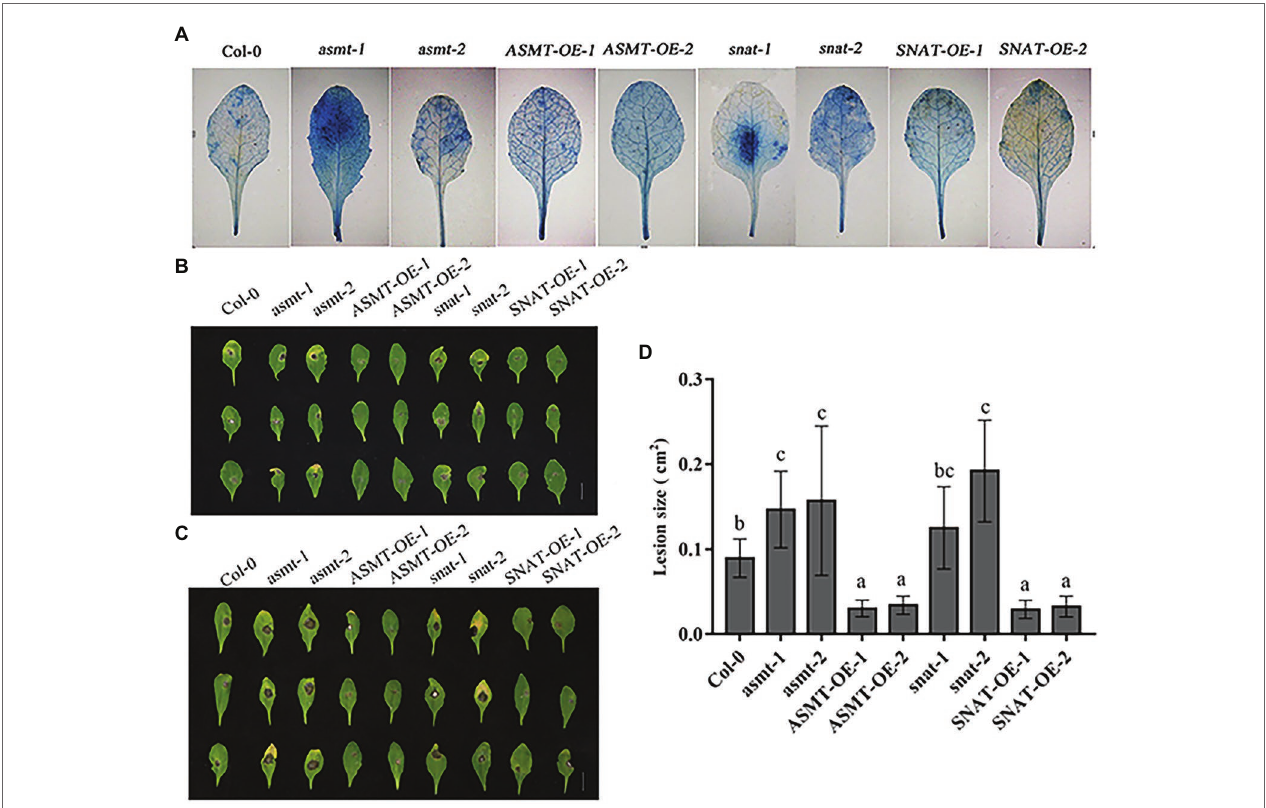
FIGURE 4 | Effects of endogenous melatonin on disease resistance to B. cinerea . (A) Trypan blue staining of leaves from different lines following B. cinerea treatment at 48 h. (B,C) Photographs of rosette leaves cut from 4-week-old Wild-type (Col-0), ASMT -overexpressed ( ASMT-OE-1 , ASMT-OE-2 ) plants, SNAT - overexpressed ( SNAT-OE-1 , SNAT-OE-2 ) plants, snat silencing lines ( snat-1 , snat-2 ), and asmt silencing lines ( asmt-1 , asmt-2 ) plants after infection with B. cinerea spores. (B) Leaves phenotype on 4 days. (C) Leaves phenotype on 6 days. (D) Lesion size. Lesion size of leaves phenotype on 6 days was measured using Image J software. The data (mean ± SD) were calculated using three replicate assays, with the SEs indicated by the vertical bars. Different lowercase letters indicate statistically significant differences ( p <